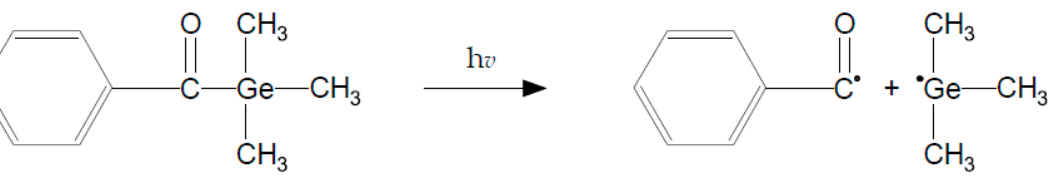
Figure 4. Alpha-cleavage of benzoyltrimethylgermane (BTMGe).